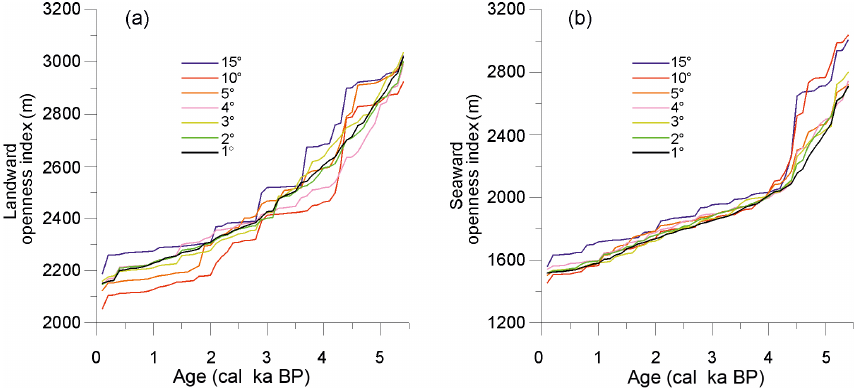
Figure 6. Calculated landward (a) and seaward (b) openness indices of Gåsfjärden over the last 5.4ky, using 1–5, 10 and 15 ◦ intervals.